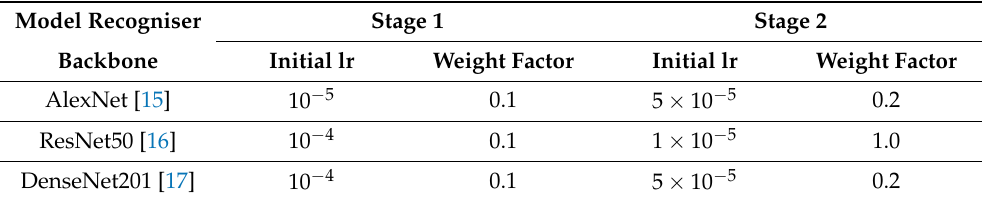
Table 3. Detailed training schema on DVMM with different model